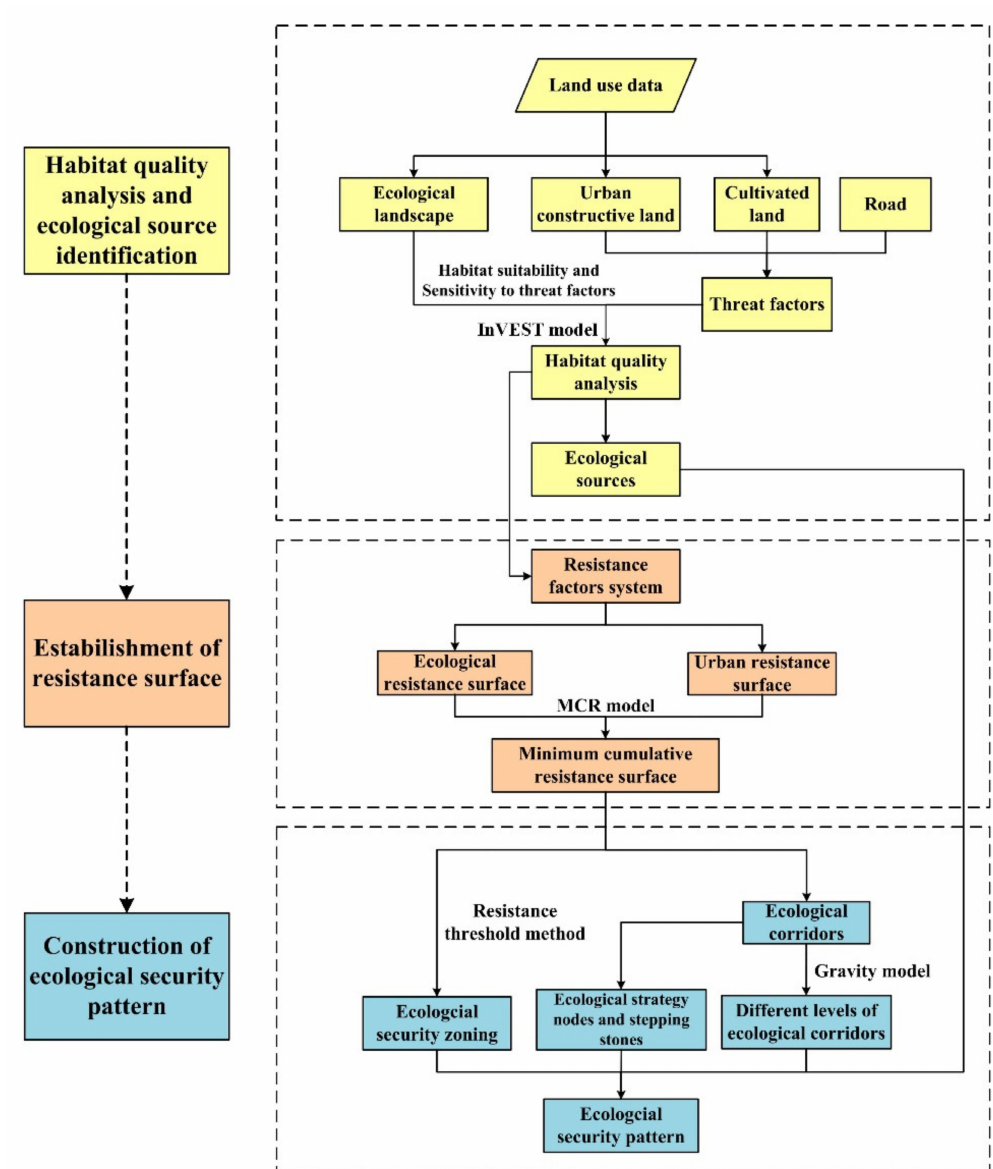
Figure 2. Flowchart of the analysis and research procedures in this